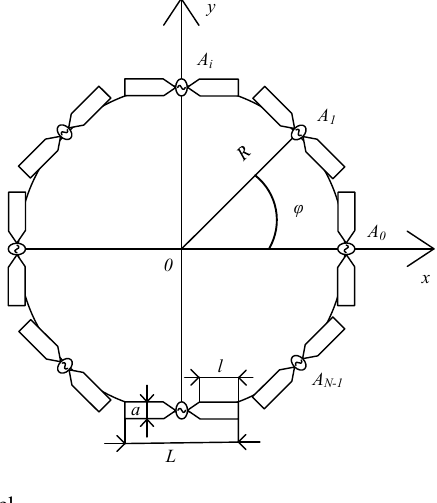
Fig. 1. Circular array